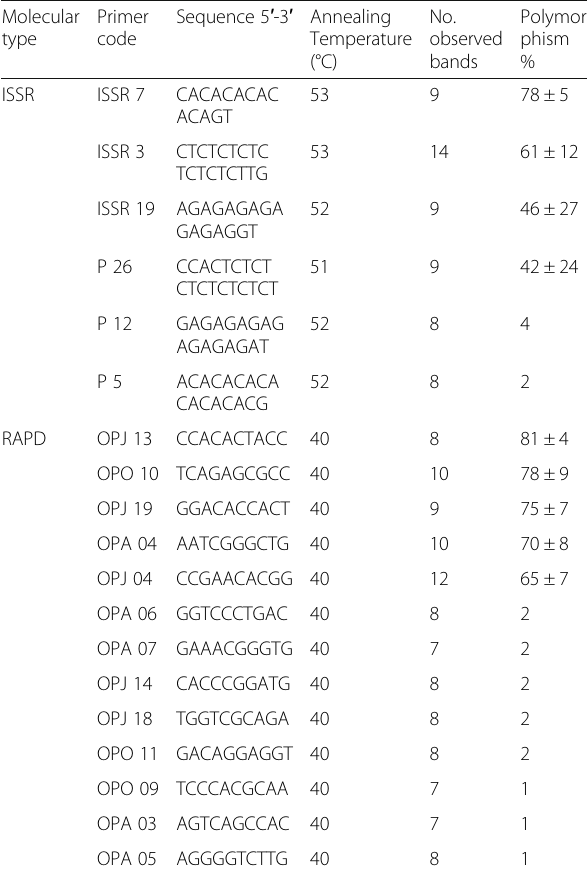
Table 1 List of primers and their nucleotide sequences, annealing temperature, number of observed bands and the percentage of polymorphism produced by different ISSR